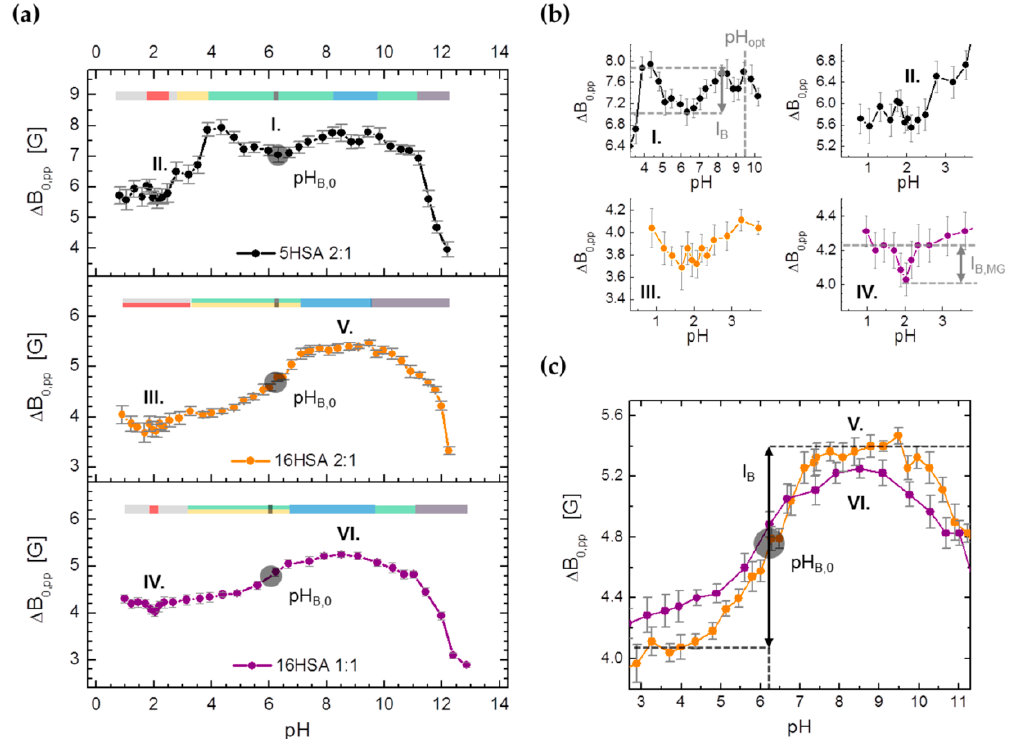
Figure 6. pH ‐ dependence of Δ B 0,pp as observed from spin probed HSA. The center ‐ field linewidths Δ B 0,pp from CW EPR spectra in Figure 3a–c are plotted in the pH range for ( a ) 5HSA 2:1 (black), 16HSA 2:1 (orange) and 16HSA 1:1 (purple). Individual phase spaces containing conformational isomers E, F, N (C), B and A are given as a color coded bar at the top of each curve according to Figure 1a. Additionally, the supposed MG state (red) and pH B,0 (black) features are given. Significant changes are marked with roman numerals (I.–VI.). In case of ambiguous curve shapes the phase space bars have been set in parallel (e.g., E and F for 16 ‐ DSA at pH < 7). ( b ) Close ‐ up representation of significant features (I.–IV.) from Δ B 0,pp of 5 ‐ DSA ‐ and 16 ‐ DSA ‐ probed HSA that can be fitted with a Gaussian model function (Supplementary Material S8). Intensity changes in the range of pH 4–9 are given as I B for 5 ‐ DSA and I B,MG for pH 1–3 for both spin probes. A local maximum feature is observed for 5 ‐ DSA at pH 9.43 that is again correlated to pH opt . ( c ) Collection and close ‐ up representation of curve features (V. and VI.) that are exclusively visible in 16 ‐ DSA ‐ probed HSA. The range of pH 3–9 can be fitted with a Boltzmann model function. The maximum change in linewidth Δ B 0,pp is termed I B and for simplicity the inflection point of the curves is again represented by pH B,0 .